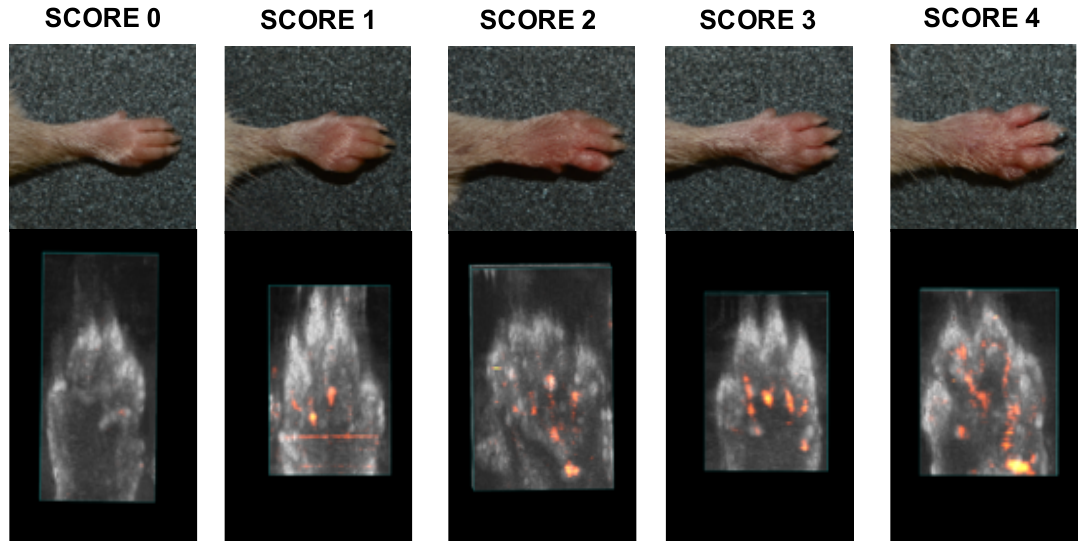
Figure 5. Arthritic paws with severity scores and associated Pulsed Wave (PW) inflammatory status.